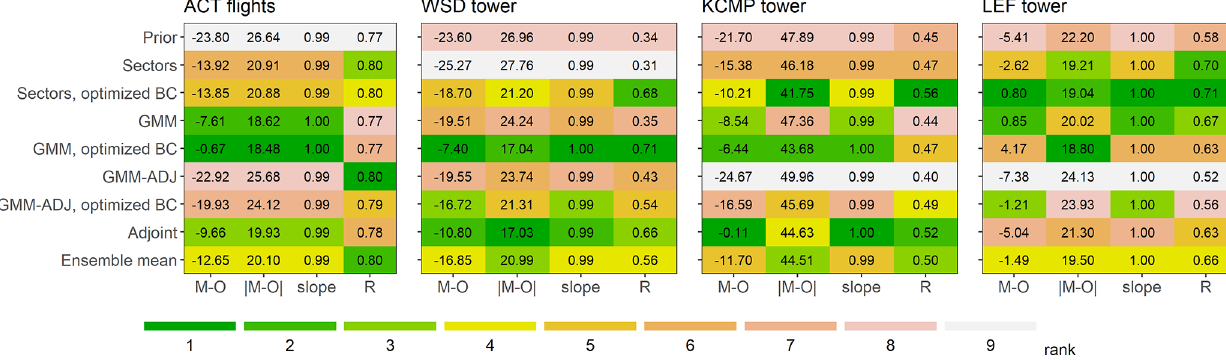
Figure 4. Inversion performance evaluation against independent observations from alternate years. Evaluation datasets include airborne mea- surements from the ACT-America campaign and tall tower measurements from Wessington South Dakota (WSD), Rosemount Minnesota (KCMP), and Park Falls Wisconsin (LEF). Each matrix displays summary performance statistics for the seven inversions, and for the ensem- ble mean, with respect to the indicated evaluation dataset. Columns in each matrix show the model mean bias (M-O; ppb), mean absolute bias ( | M-O | ; ppb), model:measurement slope (note this is within 1% of unity in all cases) and model:measurement Pearson’s correlation coefficient ( R ). Values are colored by rank for the above criteria. See Sect. 2.4 for